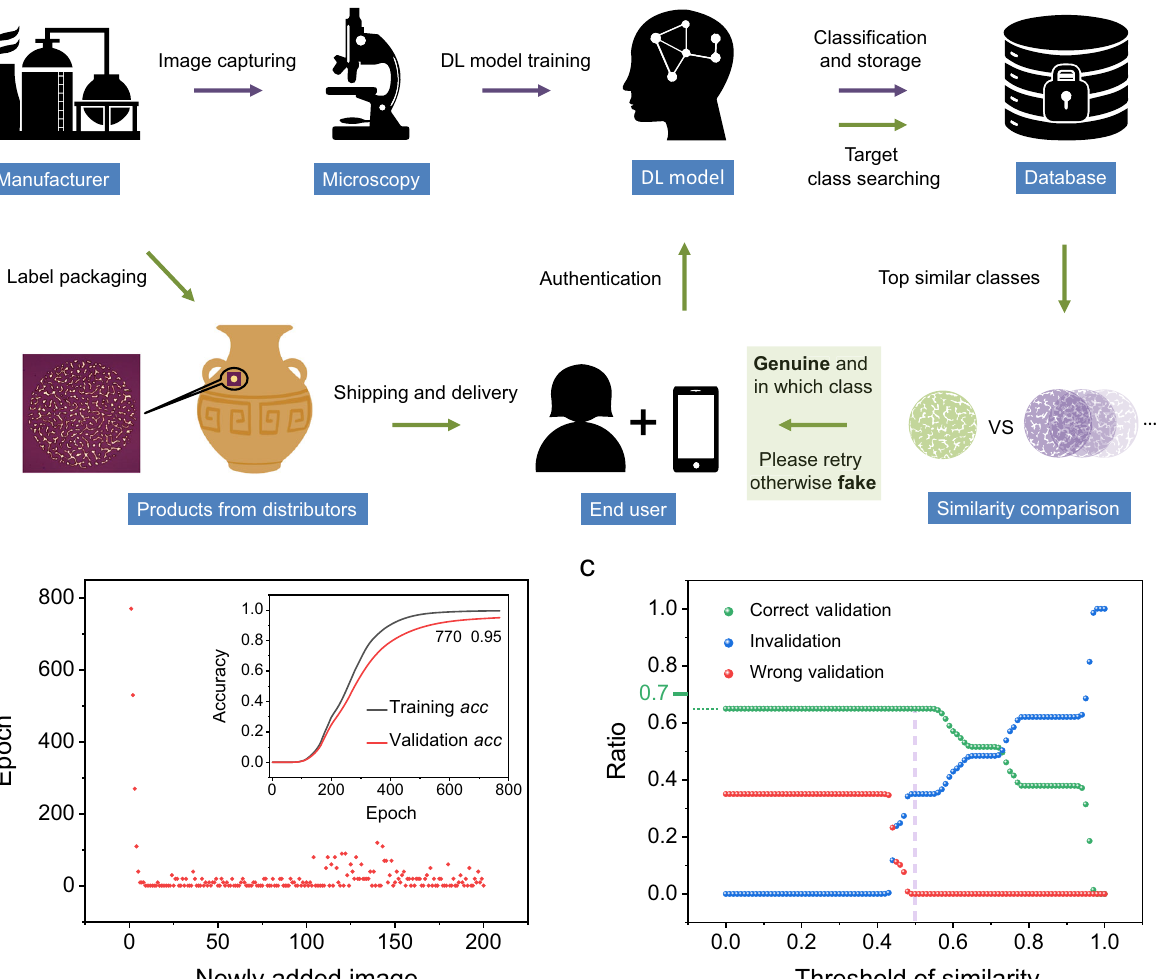
Fig. 4 | Deep learning-based authentication system and anti-counterfeiting strategy. a Conceptual schematic of the product authentication fl ow. Two pipe- linesareusedthroughouttheentireprocess:(i) “ Registration ” :Formanufacturers, they are mainly responsible for training the deep learning model and building up thekeydatabase;(ii) “ Authentication ” :Forendusers,theyonlyneedtocapturethe image and upload it to the database for decoding. b The training epoch of the classi fi cation model as a function of the newly added PUF patterns, showing a gradually stable epoch below 40. The inset shows a plot of the training and